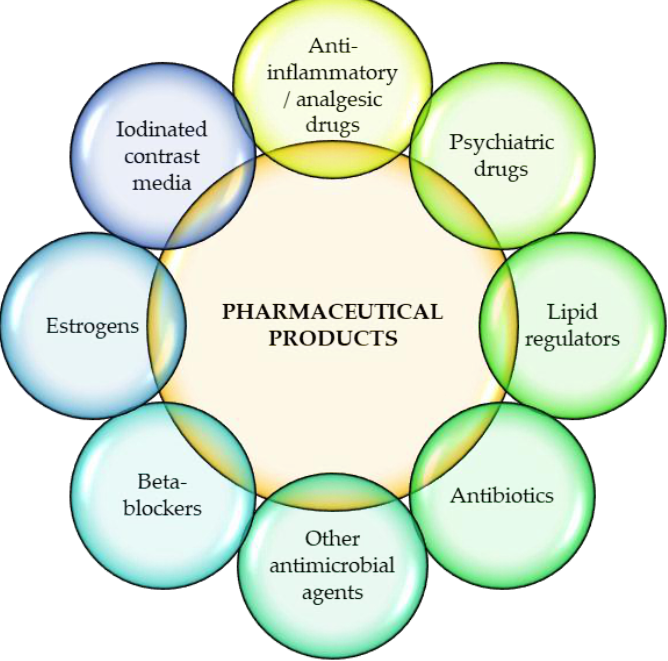
Figure 14. Pharmaceutical products categories (authors creation).